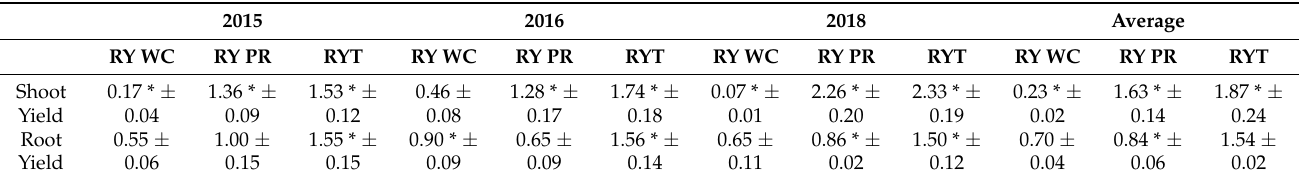
Table 3. Relative shoot and root yields of white clover (RYWC, n = 4), perennial ryegrass (RYPR, n = 4), and relative yield total (RYT, n = 4) of the averaged eight white clover genotypes in mixture with perennial ryegrass (WC1_PR–WC8_PR) for 2015, 2016, and 2018. Given are means and standard errors. Asterisks indicate values significantly different from 0.4 for RYWC, 0.6 for RYPR and 1 for RYT ( p ≤ 0.05, t -test). RYT = relative yield